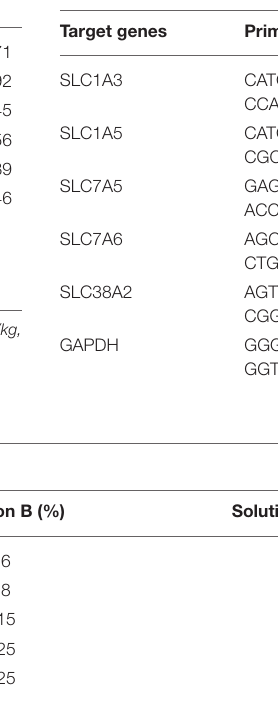
TABLE 3 | Primer sequences used for qRT-PCR analysis of target genes in lactating goats.